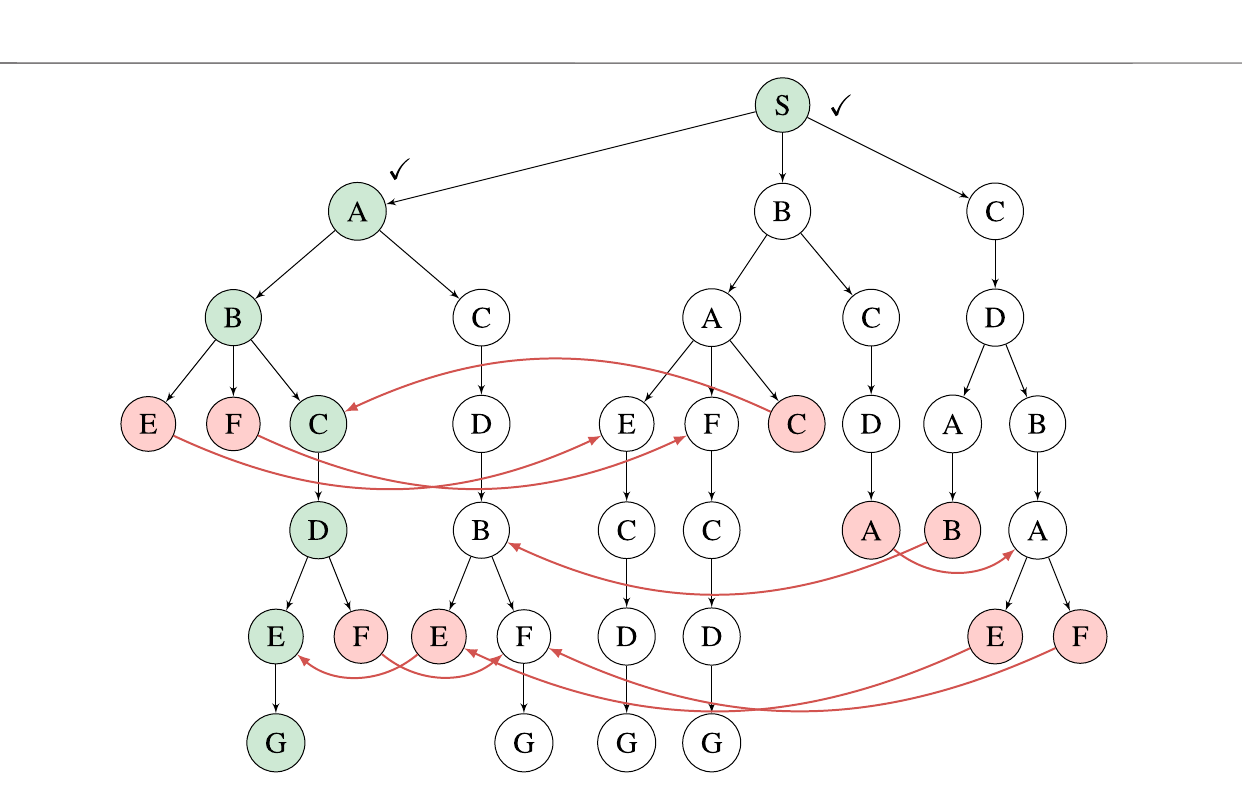
FIGURE2| VisualizationofaB&BsearchtreefortheRTSGmodelin Figure1 .ThisexpandedsearchtreemakesuptheTaskRoadmap.Theinitialtasksequenceis marked in green and completed nodes have a checkmark. Pruned nodes are red and have red pruning edges.